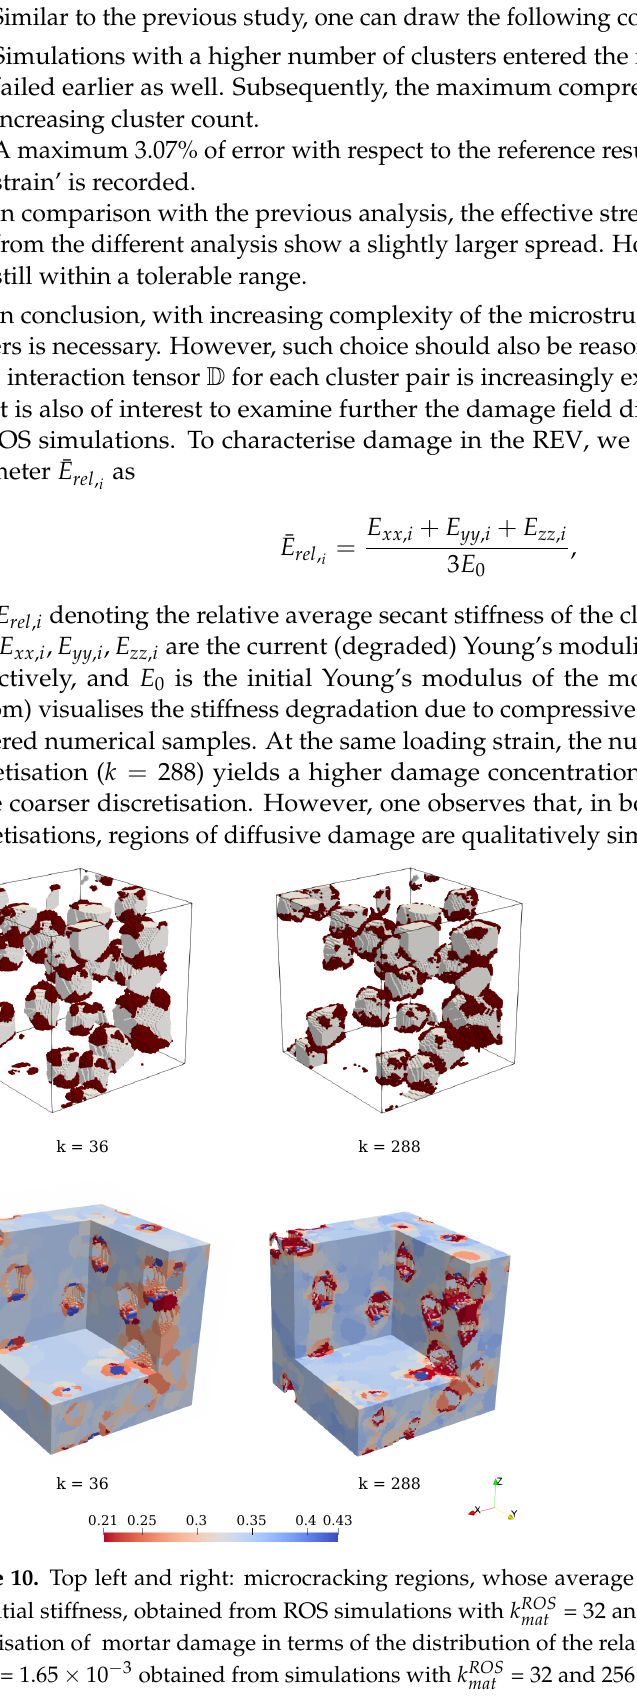
= 32 and 256. Bottom left and right: mat ) at i = 32 and mat